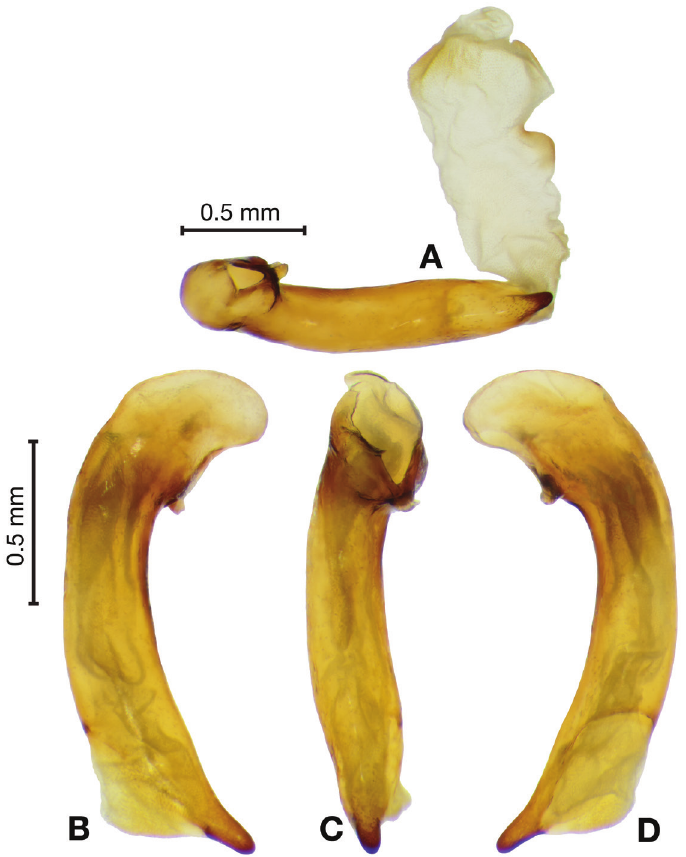
Figure 22. Digital images of male genitalia of Catascopus ( s. str. ) asaharti sp. n. A ventral aspect, en- dophallus everted B right lateral aspect C ventral aspect D left lateral aspect.